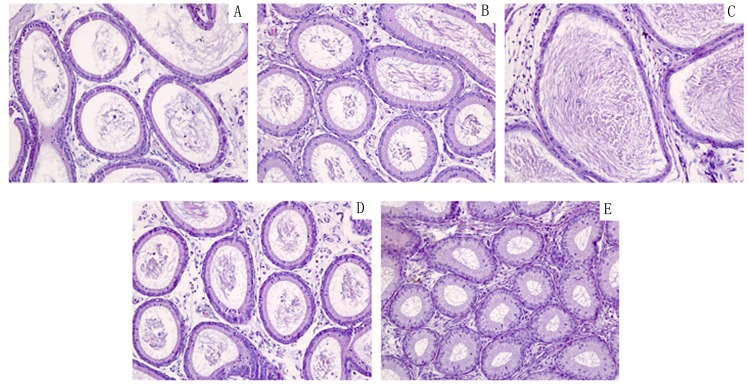
Control group and DEHP experimental group offspring (F1-F4) male rat’s epididymis histology expression.Normal control group of testicular seminiferous tubule epithelial developed normally, we can observe each stage sperm cells and a large number of sperm cells in the epididymis pipe. DEHP experimental F1 generation observed seminiferous tubule epithelial obvious atrophy, less sperm cells, pathologic hyperplasia of interstitial cells, number of sperm in the epididymis lumen scarce or lack, luminal epithelium cell falls off. F2 generation of rat testis partial seminiferous tubule epithelium atrophy, sperm cells less; F3 and F4 generation were tend to be normal, sperm cells grading well. A:F1;B:F2;C:F3;D:F4 E: Control (200×).